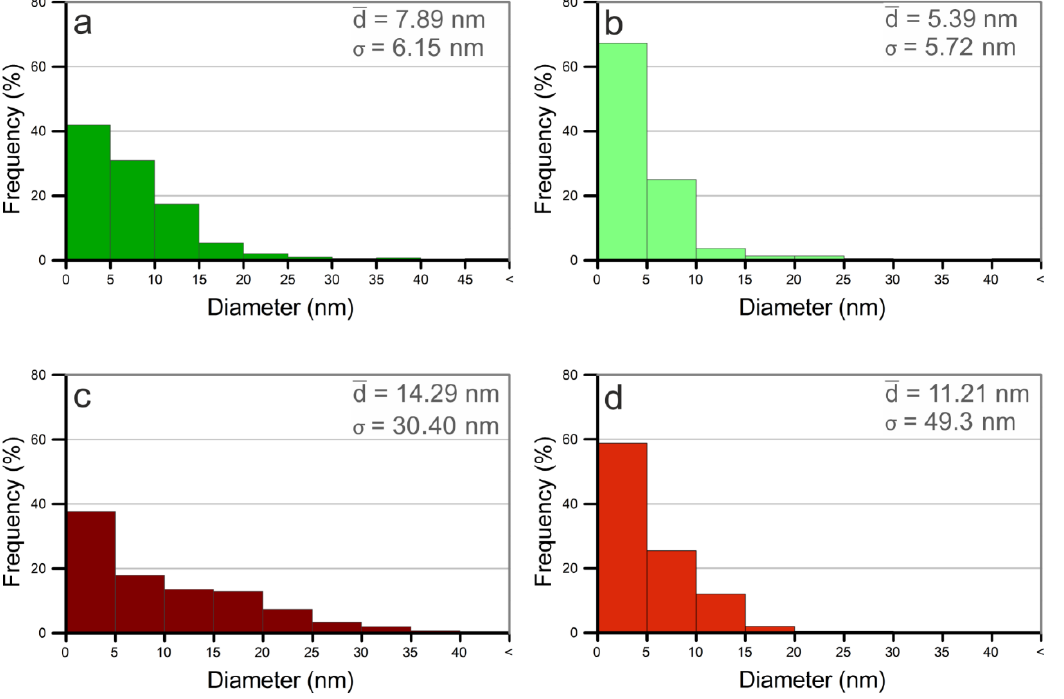
Figure 4. Size distribution of Pd nanoparticles synthesized by laser ablation with ( a ) 532 nm of wavelength in water, ( b ) 532 nm in methanol, ( c ) 1064 nm in water and ( d ) 1064 nm in methanol.